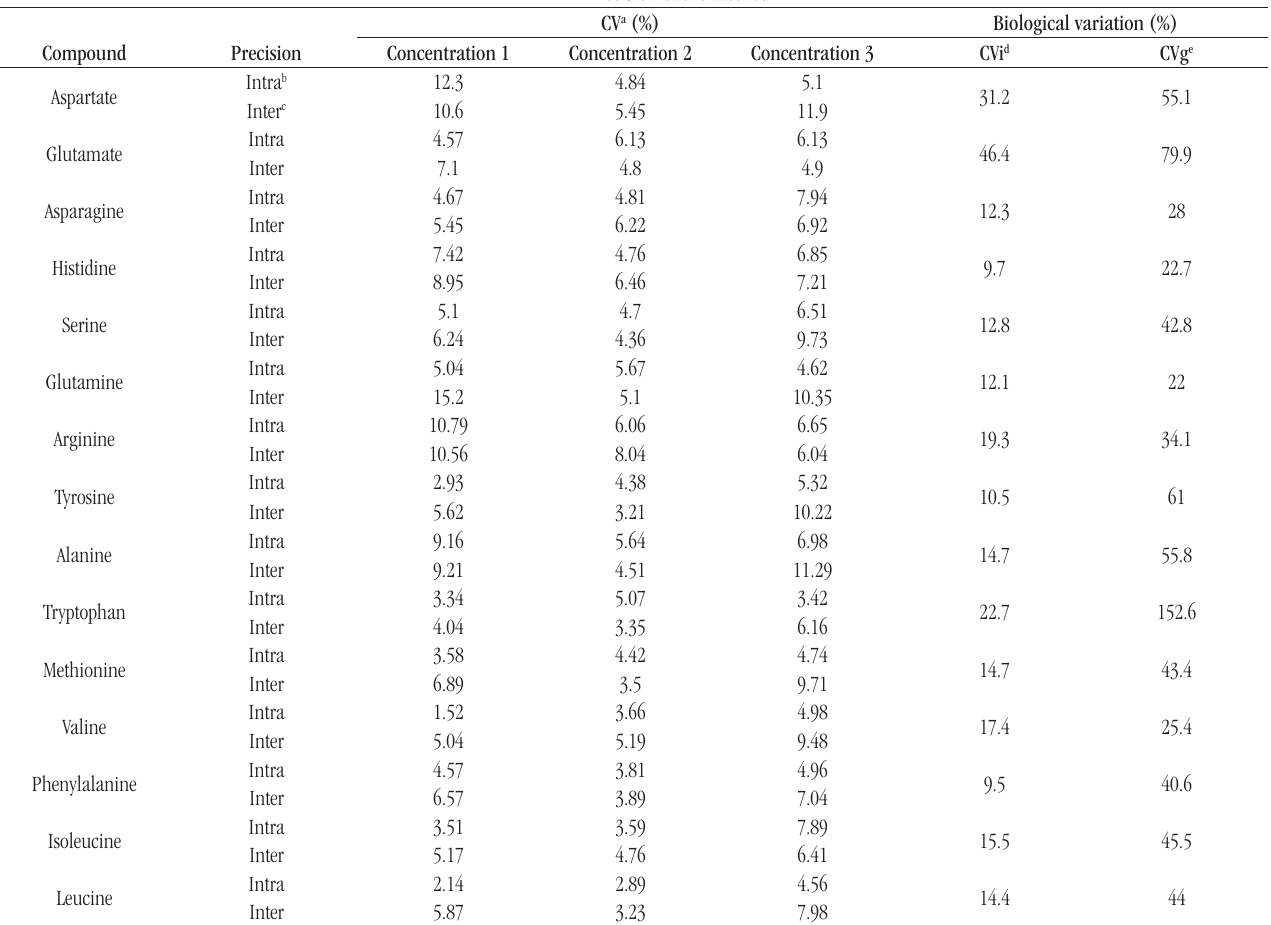
taBLE 4 − Precision of the method